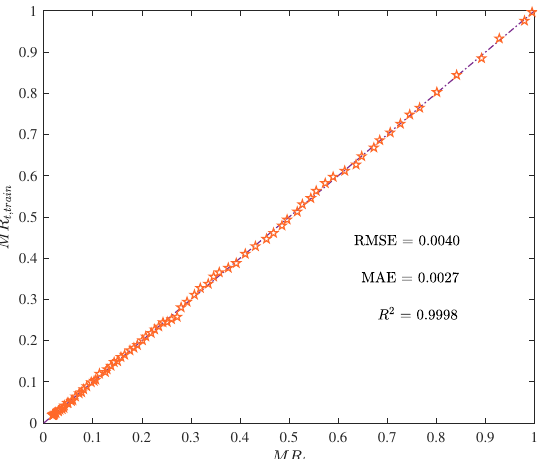
Figure 8. The moisture ratio given by the trained ELM model MR t , train vs. the actual moisture ratio MR t